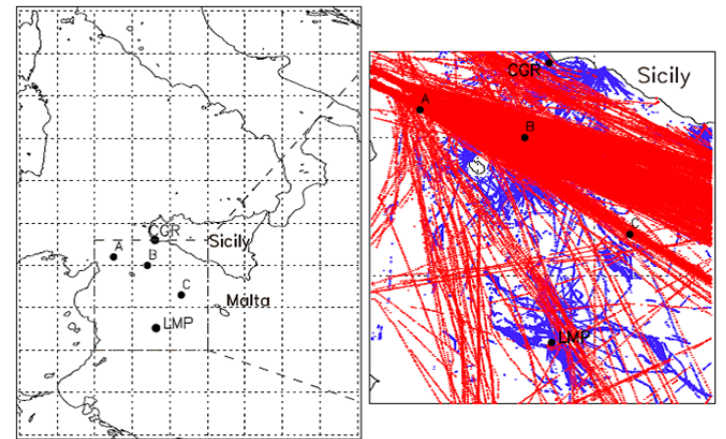
Figure 1. Map of the study area with the sites of Lampedusa (LMP) and Capo Granitola (CGR) are displayed in the left panel. A–C indicate the three sites selected to study the stability of the boundary layer in the Straight of Sicily (see Sect. 3.2.2). The ship routes in the study area during the first 10 days of June 2013 are displayed in the right panel. Red and blue dots show the routes of merchant and fishing vessels,